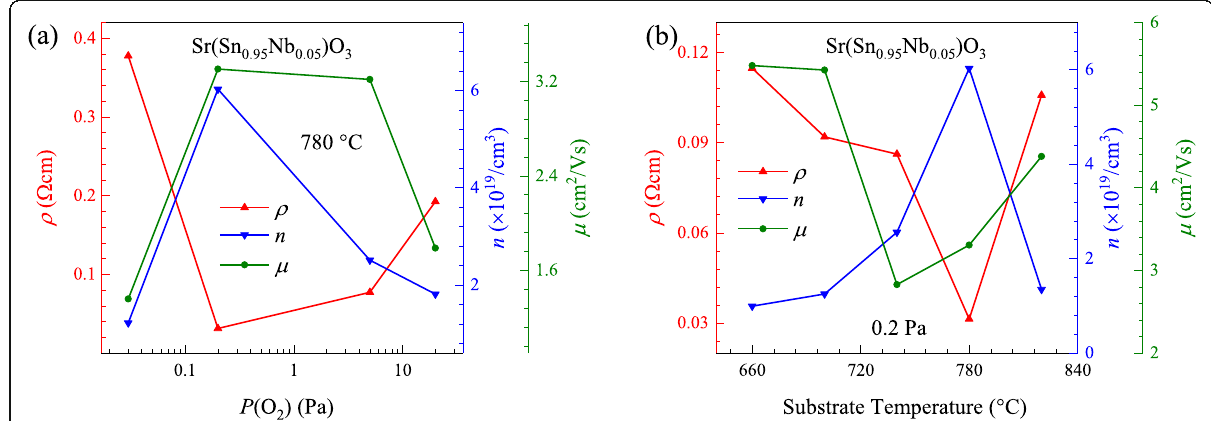
Fig. 4 Resistivity, carrier concentration, and mobility of the SSNO films as a function of ( a ) oxygen pressure from 20 to 0.03 Pa and ( b ) substrate temperature from 660 to 820 °C measured at room